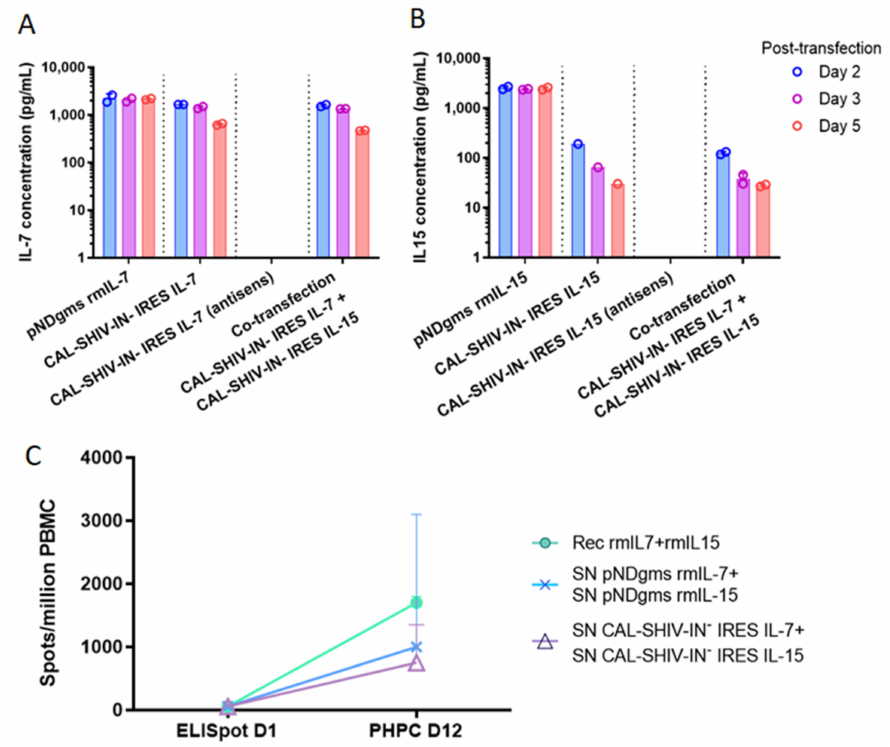
Figure 2. Expression and functional analysis of secreted IL-7 and IL-15 cytokines: HEK 293T cells were transfected with either pNDgms-rmIL-7, pNDgms-rmIL-15 or with CAL-SHIV-IN − IRES- rmIL-7 and CAL-SHIV-IN − IRES-rmIL-15 alone or co-transfected with both CAL-SHIV-IN − IRES cytokines. Vaccines with antisense cytokine cassette were used as negative controls. Supernatants of transfected cells were harvested at days 2, 3 and 5 and quantified for IL-7 ( A ) and IL-15 ( B ). Median values of two independent experiments were used to draw the columns. ( C ) Human PBMCs from a BCG-vaccinated donor were used in overnight and PHPC assay using the homeostatic cytokines. Quantified spots after 20 h stimulation with BCG vaccine are noted as ELISpot day 1. Spots quantified at 12 days stimulation with indicated cytokines ( – o – ): recombinant cytokines; ( – x – ): supernatants of pNDgms transfected HEK 293T cells; ( – ∆ – ): supernatants of CAL-SHIV-IN − IRES cytokines transfected HEK 293T cells. Median values with 95% CI of the 3 repeated experiments (day 12) are